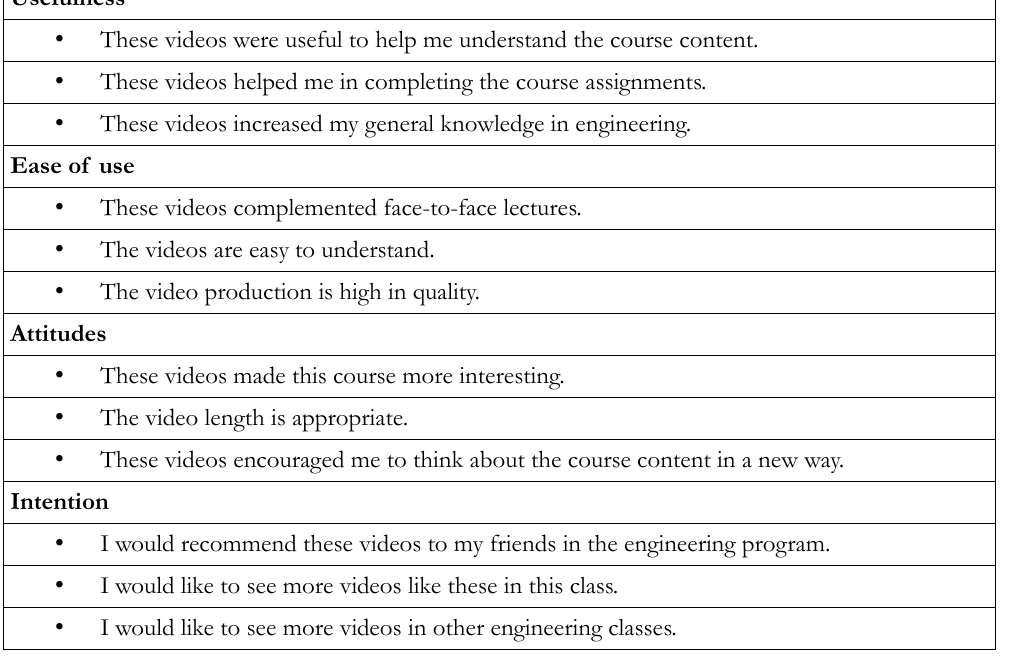
Table 1. Scales Used in the Survey